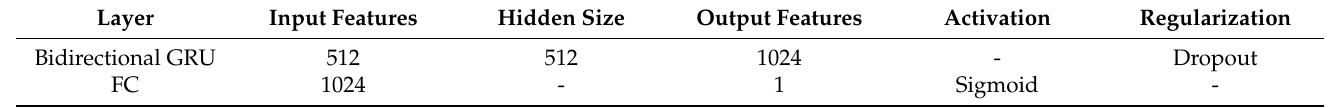
Table A4. The bidirectional GRU that was added on top of the architecture that is presented in Table A2, used for CNN + RNN approach. The layer that is highlighted in purple is only used for the regression and the classification approach (not for the FSL approach). For the regression approach, we used no activation function and the activation function that is highlighted in green is used for the classification approach (not for the FSL